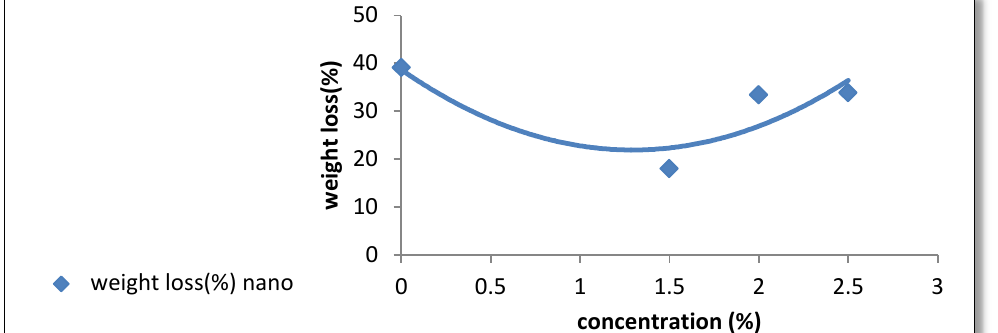
Fig. 6: Enzymatic degradation of nano SiO